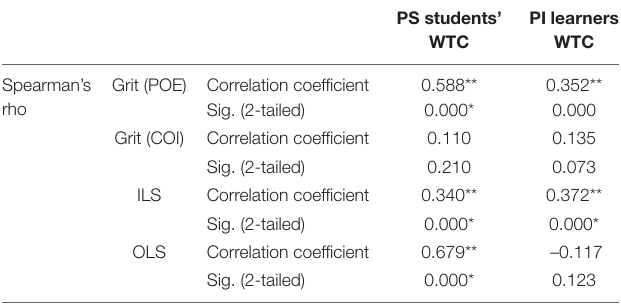
TABLE 5 | Spearman’s rho correlation, grit, L2MSS, and WTC for public school students and private institute learners.